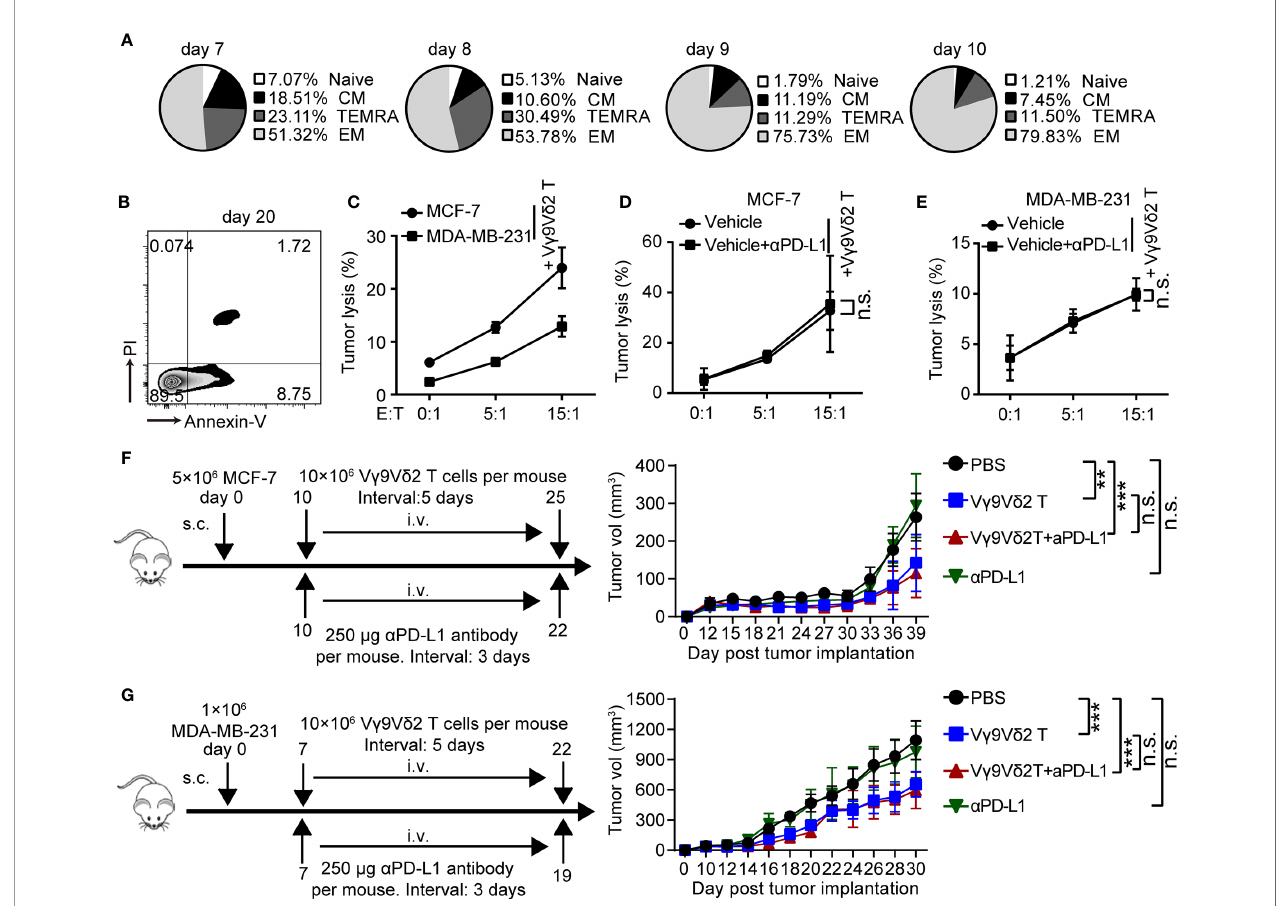
FIGURE 3 | V g 9V d 2 T cells could kill breast cancer cells and restrain cancer growth, but without enhanced function with anti-PD-L1 addition. (A) Subsets of V g 9V d 2 T cells cultured on day 7, 8, 9, and 10. According to the CD45RA and CD27 expression, the V g 9V d 2 T lymphocytes were subdivided into: CM (CD27 + CD45RA − ), naïve (CD27 + CD45RA + ), TEMRA (CD27 − CD45RA + ), and EM (CD27 − CD45RA − ). (B) Survival of V g 9V d 2 T cells cultured to day 20. Cell apoptosis (PI + Annexin-V + ) were analyzed by fl ow cytometry. (C) Cytotoxicity of V g 9V d 2 T cells toward breast cancer cells (MCF-7 or MDA-MB-231) at the indicated effector to target ratio (E:T). The percentages of dead cells out of whole target cells were identi fi ed as PI + ( n =5). (D, E) Cytotoxicity of V g 9V d 2 T cells had no obvious difference at the indicated E: T ratio with MCF-7 or MDA-MB-231 cells (target cells) pretreated with vehicle or anti-PD-L1 (10 m g/mL) for 6 hours ( n =5). Dead target cells out of the total target cells were recorded. (F, G) Schematic protocols of tumor growth model (left). i.v., intravenous; s.c., subcutaneous. Progression of MCF-7 tumors and MDA-MB-231 tumors in mice was assessed in NOD/scid mice. n =5 mice per group. Experiments were independently repeated three times (F, G) . V g 9V d 2 T cells from healthy donors were expanded with ZOL. Data represent mean ± SD (C – G) . Unpaired Student ’ s t -test (C – E) ; two-way analysis of variance (ANOVA) (F, G) . Signi fi cance was set to P < 0.05 and represented as * P < 0.05, ** P < 0.01, *** P < 0.001, and **** P < 0.0001, n.s. , not signi fi